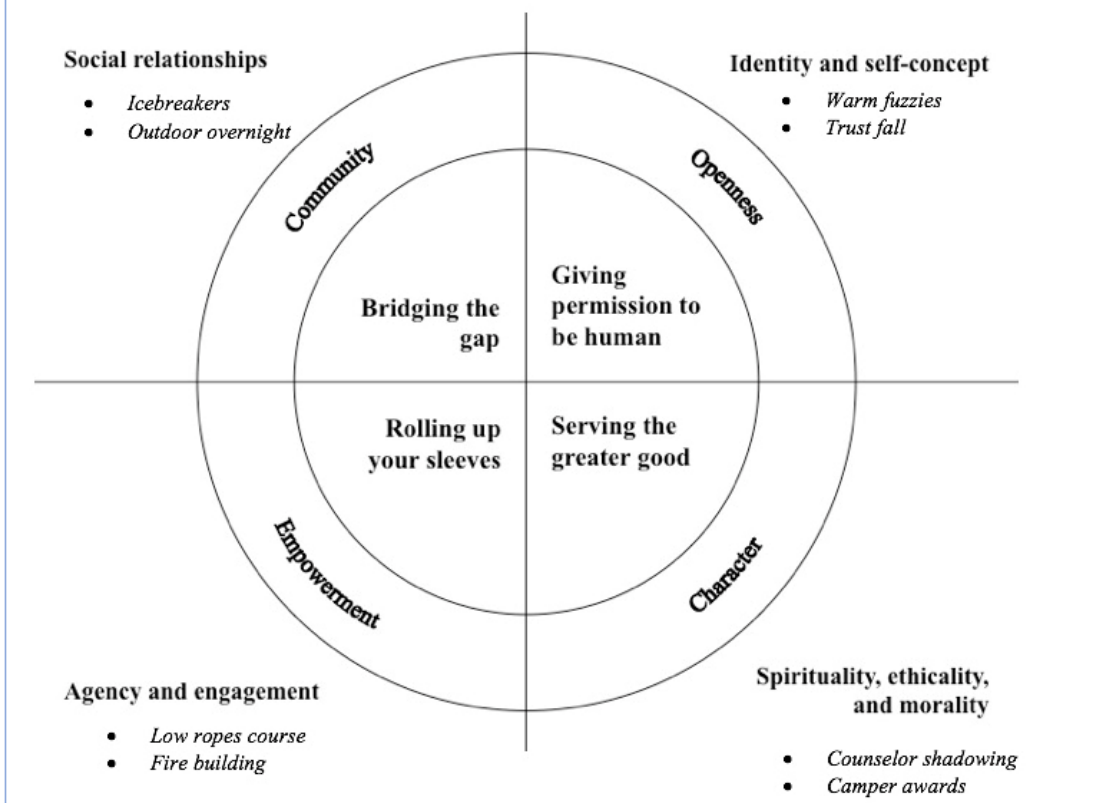
Figure 2: Camp Activities Mapped to the Camp-Based Model of Youth Leadership